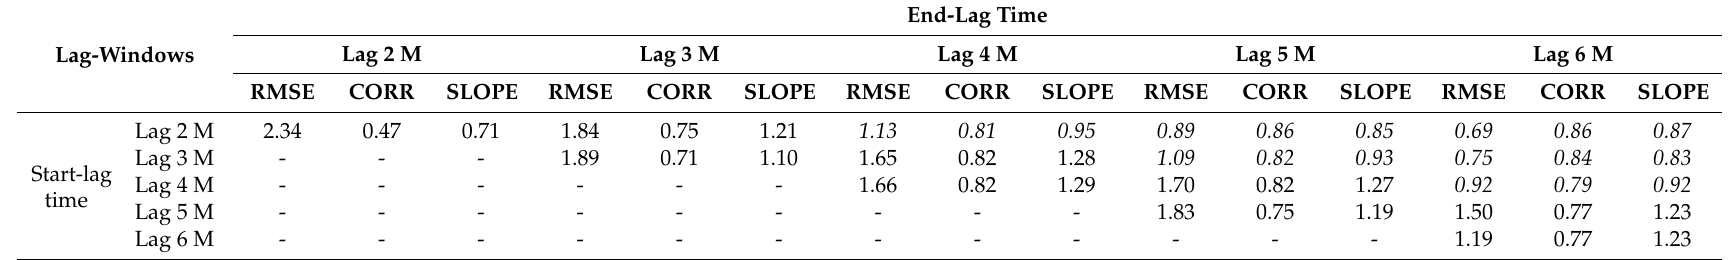
Table 1. Statistical evaluation of potential wind speed forecasting models for different lag-windows during the fitting period. The values in bold italics indicate goodness-of-fit